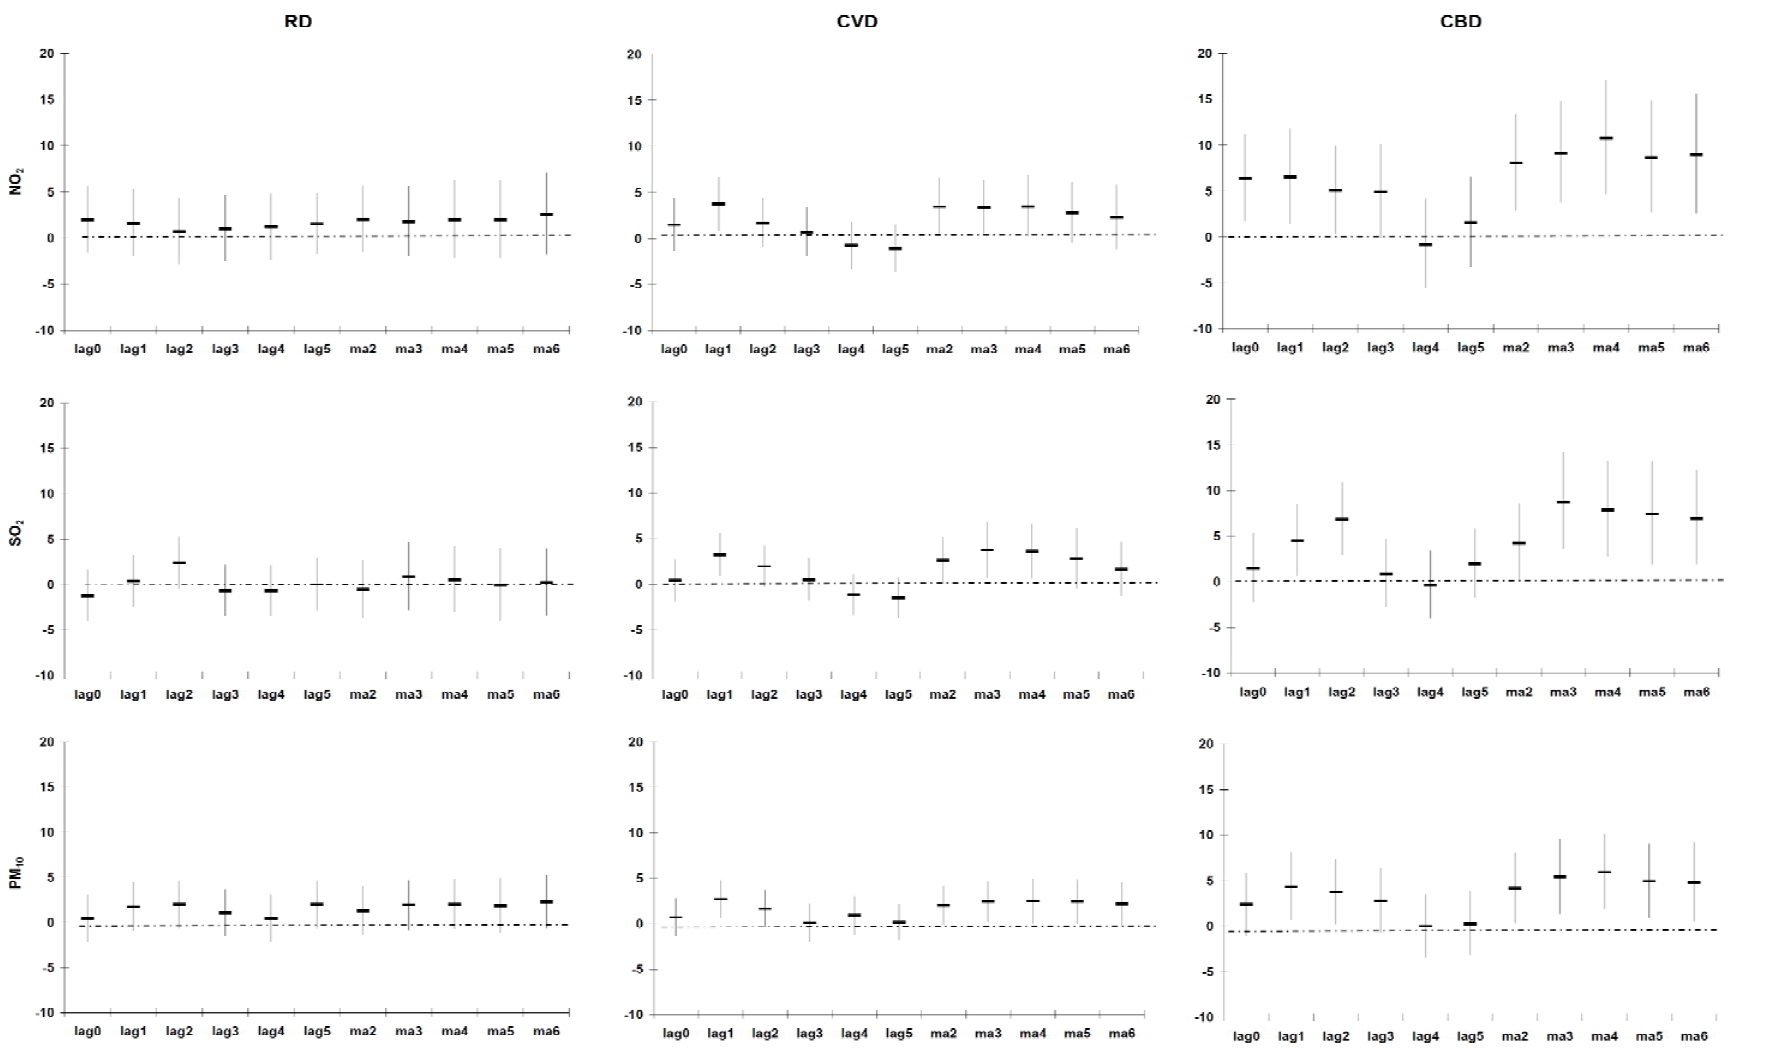
, NO and SO 10 2 2